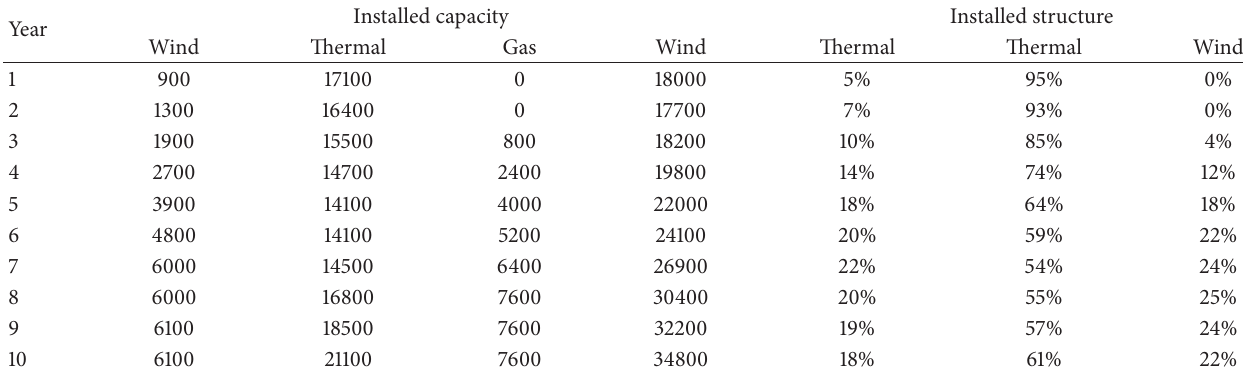
Table 11: Interregional power system planning capacity and structure in Case 2.